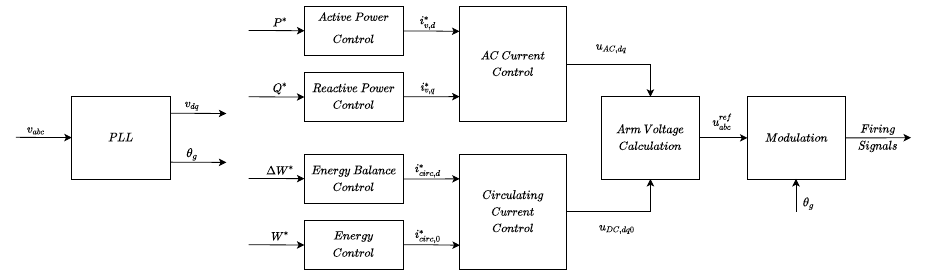
Figure 2. Block diagram of an MMC-based GFL converter in grid-feeding